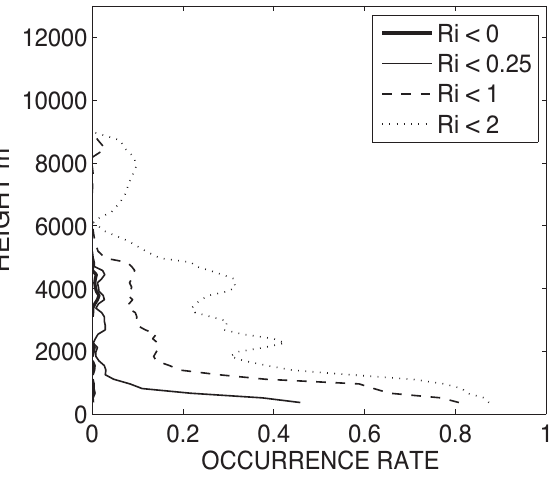
Fig. 13. Occurrence rates of turbulence observed by ESRAD, and low Richardson numbers predicted by WRF for the ESRAD loca- tion, for the whole period 23rd–25th January, 2003. WRF results based on 1km/150m grid